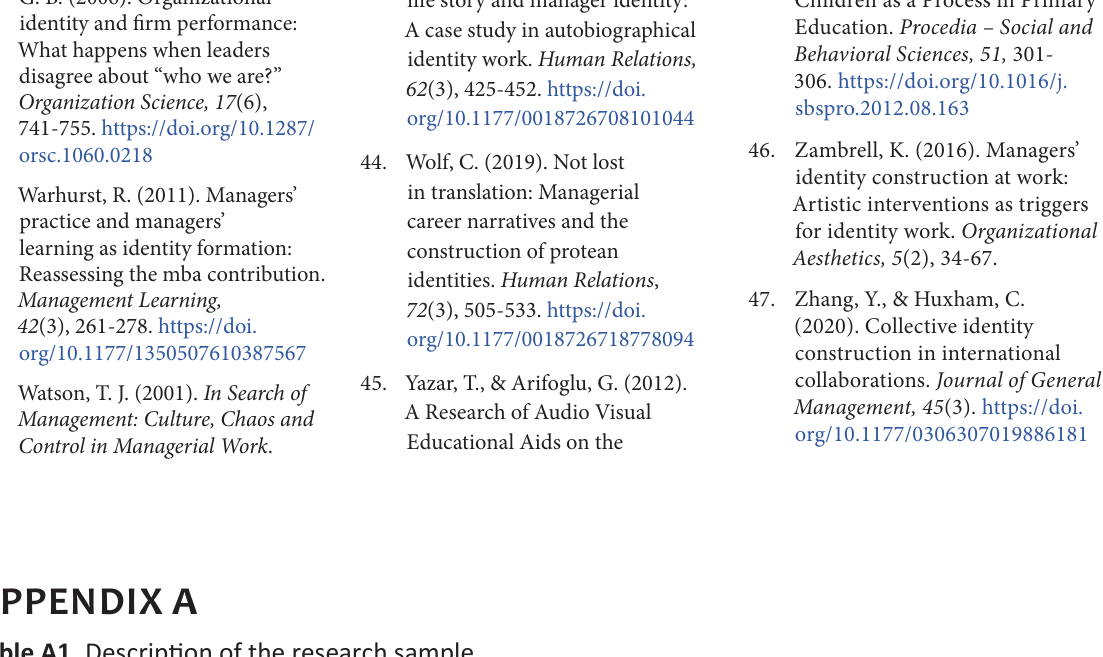
Table A1. Description of the research sample